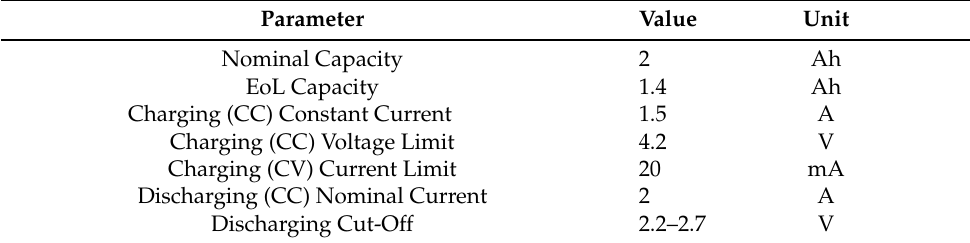
Table 1. Battery